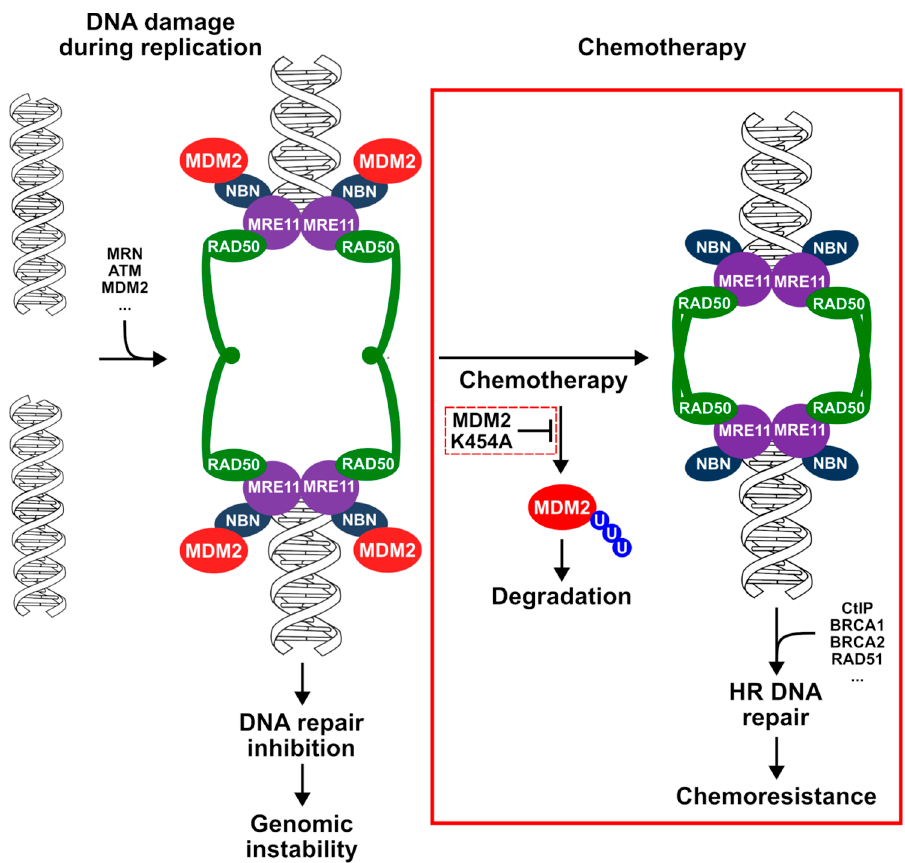
Figure 9. Proposed model of MDM2 protein action during DNA double-strand breaks repair after treatment with DNA-damaging chemotherapeutics. Chemotherapy-induced double-strand breaks stimulate activation of the kinases responsible for MDM2 dissociation from the MRN complex; MDM2 is ubiquitinated and degraded, opening the way for effective DNA repair through the homologous recombination mechanism and resulting in the acquisition of chemoresistance. The novel elements of the model proposed on the basis of the results presented in our study are marked with a red box.